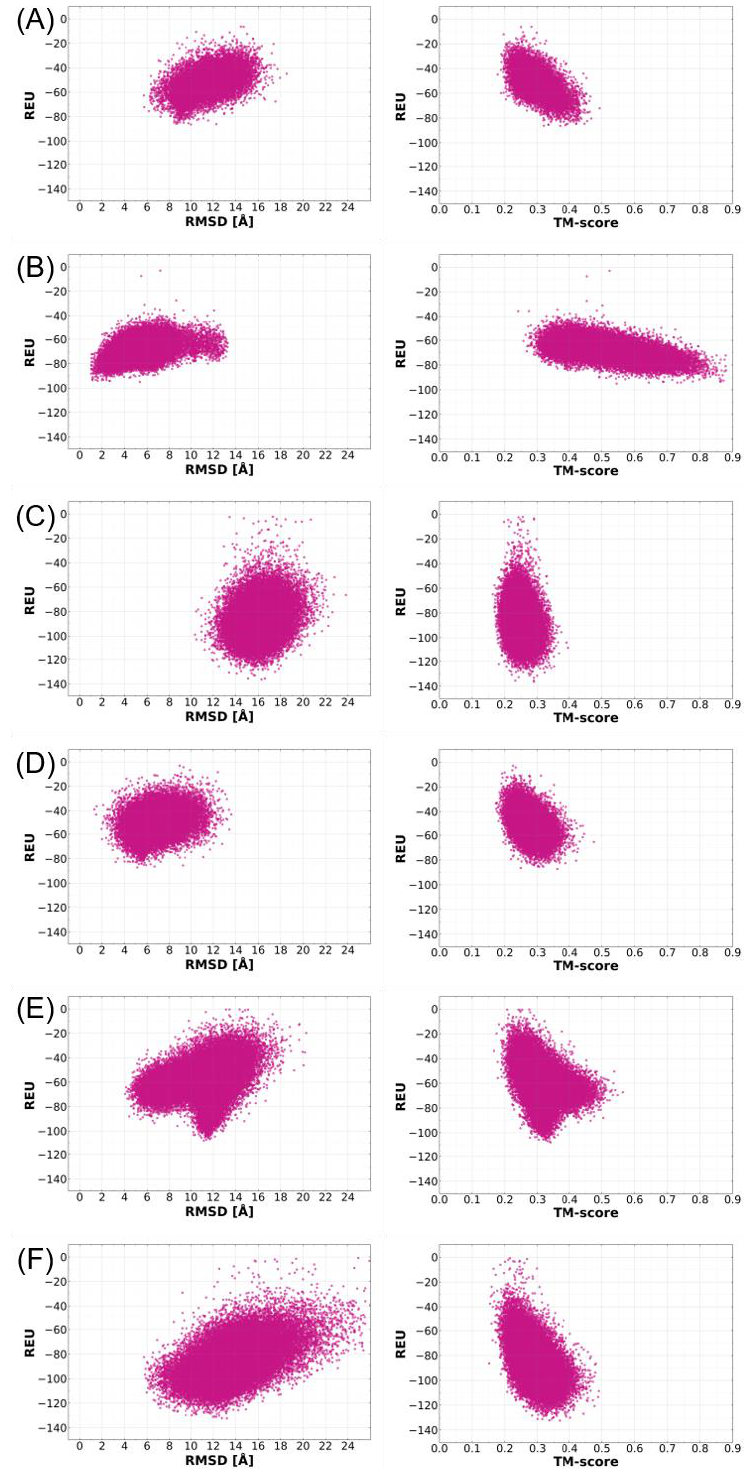
Figure 4. Scatter plots of the distribution of Rosetta energy scores (in Rosetta energy units (REU)) versus RMSD ( left panel ) and TM-score ( right panel ) of MAX effector templates ToxB ( A ), AvrPib ( B ), AvrPik ( C ), AvrCO39 ( D ), AvrPia ( E ), and AvrPiz-t ( F ). RMSD was calculated as the average deviation between the C α of all residues in each model and the native structure (in Ångstrom). TM-score values above 0.5 indicate similarity in fold between the ab initio model and native structure. Plots were derived based on structural models obtained with the highest nstruct of 50,000 models per run, and only models with negative REU values were included in the